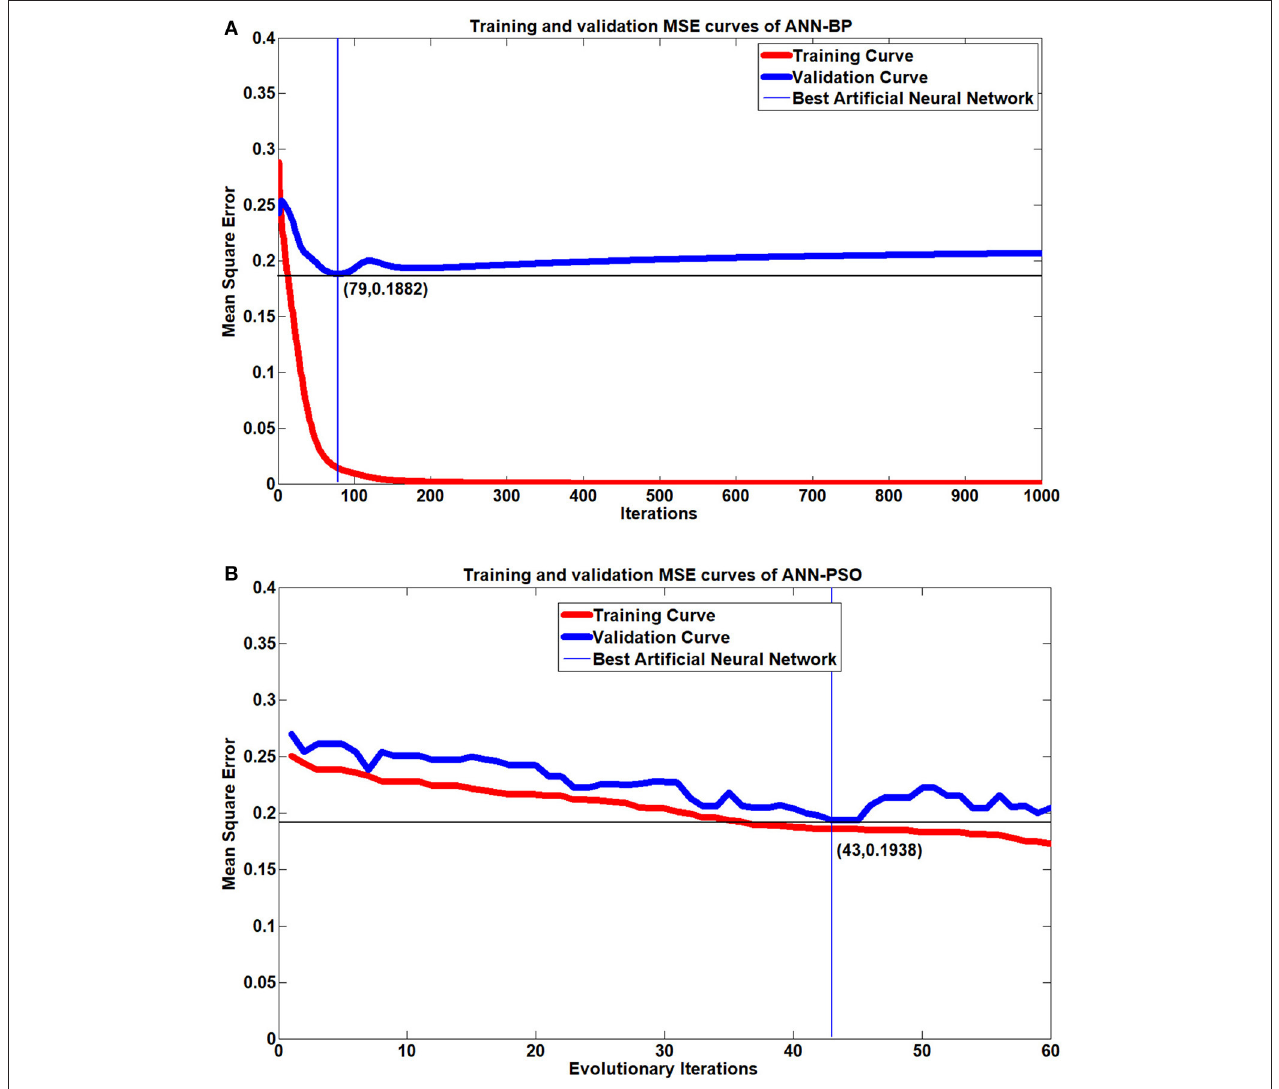
FIGURE 5 | Mean square error (MSE) of the training and validation set for the early stopping of the classifier. (A) Training and validation MSE of artificial neural network (ANN)-back-propagation. (B) Training and validation MSE of ANN-particle swarm